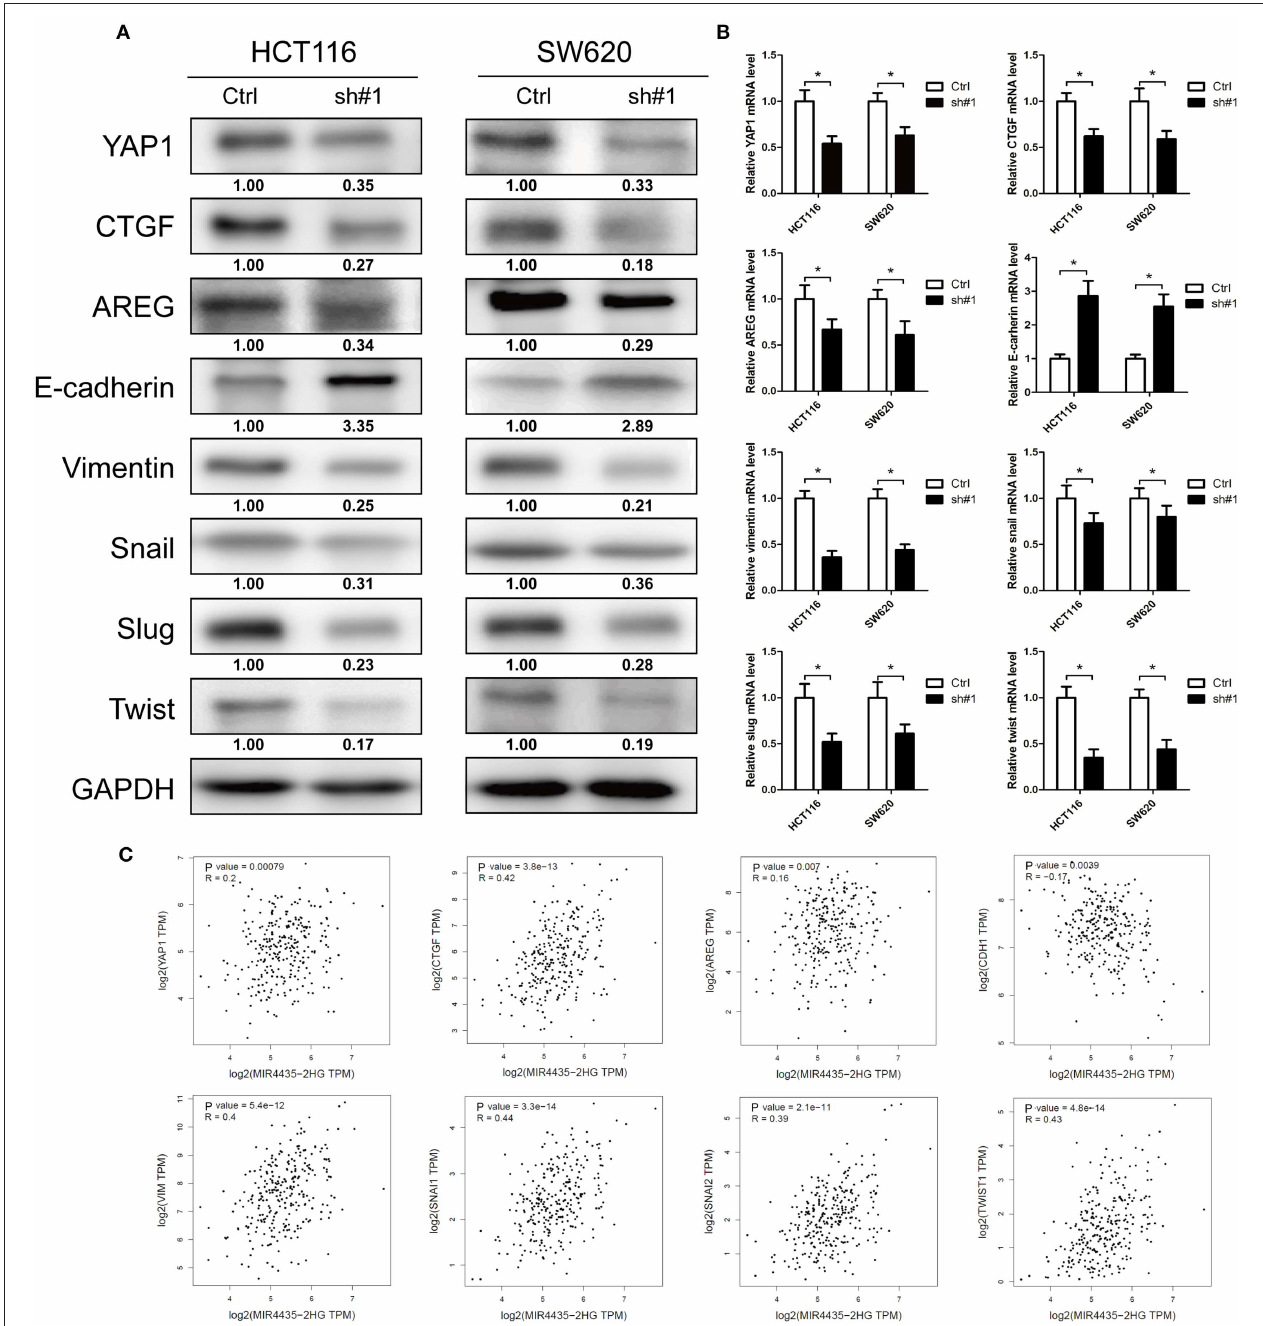
FIGURE 5 | Downregulation of MIR4435-2HG inhibited tumor growth and epithelial-mesenchymal transition (EMT) via the Hippo signaling pathway. (A) Western blotting results show decreased protein levels of YAP1 following the knockdown of MIR4435-2HG in HCT116 and SW620 cells. Tumor growth markers CTGF and AREG expression levels were decreased after knockdown MIR4435-2HG in HCT116 and SW620 cells. Protein expression levels of mesenchymal markers vimentin, Snail, Slug, and Twist were down-regulated, and epithelial marker E-cadherin expression was increased after knockdown of MIR4435-2HG in HCT116 and SW620 cells. (B) Levels of YAP1, CTGF, AREG, E-cadherin, vimentin, Snail, Slug, and Twist mRNAs were measured by real-time reverse transcription polymerase chain reaction (RT-PCR). (C) Correlation of MIR4435-2HG with YAP1, CTGF, AREG, E-cadherin, vimentin, Snail, Slug, and Twist according to Gene Expression Profiling Interactive Analysis (GEPIA) of colorectal cancer (CRC) data in The Cancer Genome Atlas (TCGA) database. * P < 0.05.